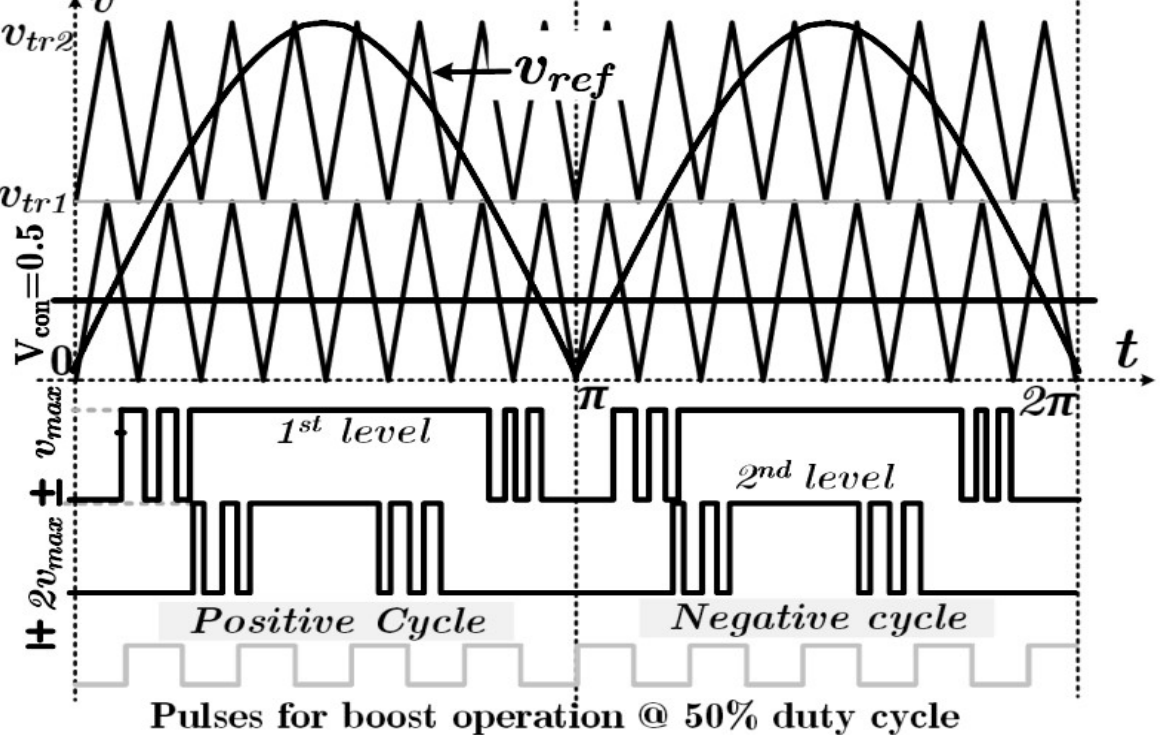
Figure 3. In this reference signal (v ref ) is compared with triangle carrier signals (v tr1 , v tr2 ) for inverter operation , and constant signal ( v con ) for boost operation. The v con compared output is given to the S B , and the rest of the comparator output is given to the inverter operation.